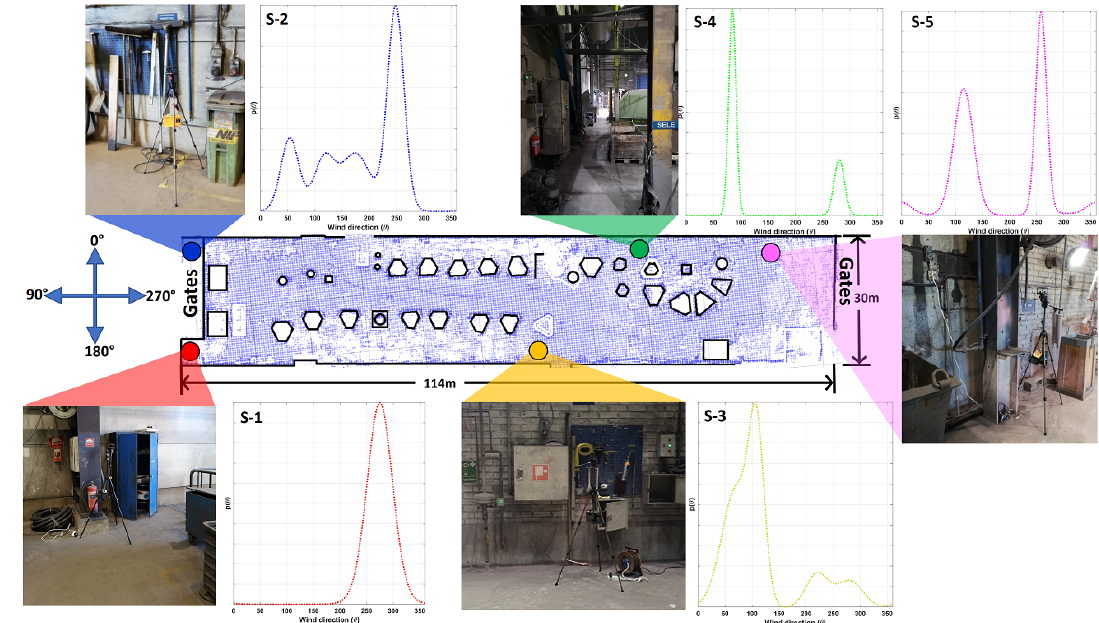
Figure 11. Summary of the characterization performed at foundry-B. At each sensor location S-1 to S-5 models mvM ( θ ) are